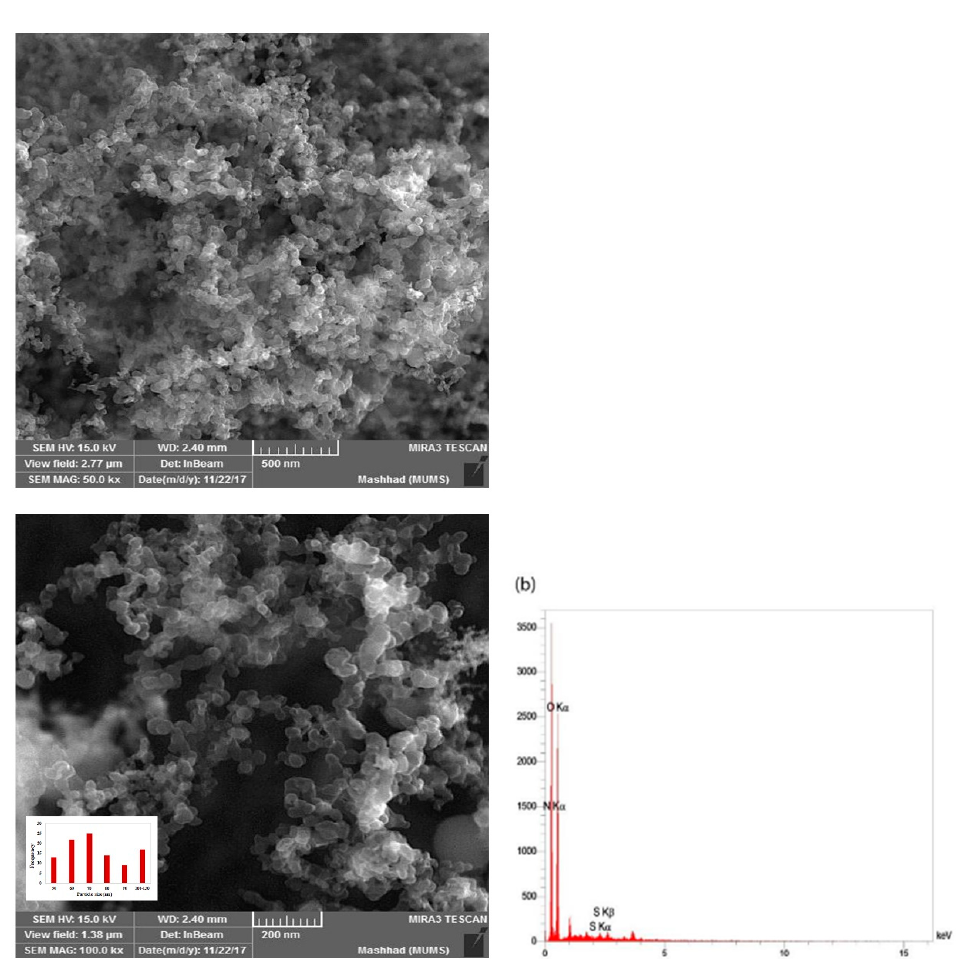
Figure 3. The size distribution and scanning electron microscope (SEM) images ( a ) with energy dispersive X-ray microanalysis (EDX) ( b ) analysis of HACSLA-NPs.